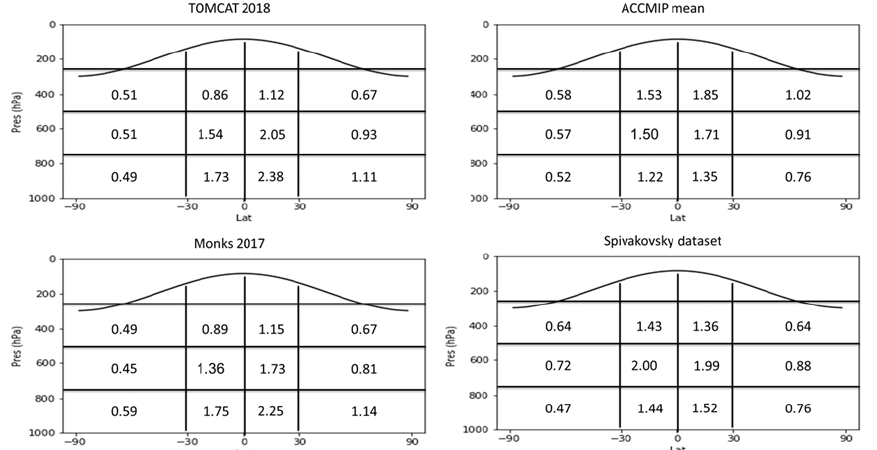
Figure 3. Annual zonal mean hydroxyl radical (OH) concentrations ( × 10 6 molec.cm − 3 ) divided into 12 subdomains, as recommended by Lawrence et al. (2001). The simulated OH from this study is compared to a dataset estimated from methyl chloroform observations (Spivakovsky et al., 2000) and the Atmospheric Chemistry and Climate Model Intercomparison Project (ACCMIP) multi-model mean (Naik et al., 2013). Results from a previous version of TOMCAT from Monks et al. (2017) are also shown. A climatological tropopause, indicated by the smooth black line near the top of each panel, has been used to remove stratospheric OH.